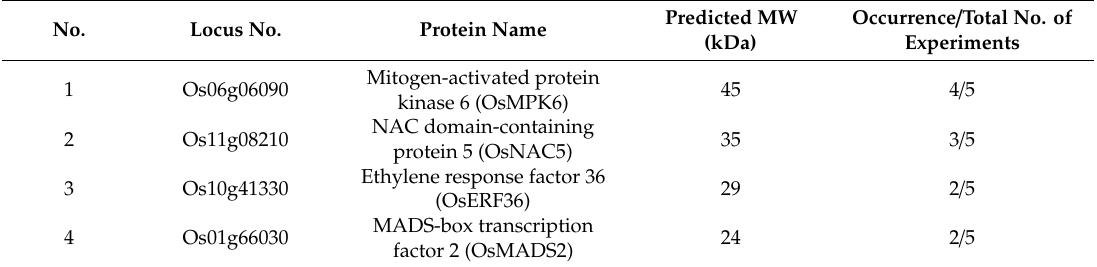
Figure 3. Identification of OsVQ13-associating proteins. ( A ) Confirmation of JA-hypersensitive phenotype in OsVQ13GFP -ox plant. Total chlorophyll content in leaf blades after treatment with 100 µ M of JA for 3 d in WT and OsVQ13GFP -ox rice plants. Values are means ± SE. Data were analyzed using Tukey’s HSD test ( n = 4 for each genotype). Bars with di ff erent letters are significantly di ff erent at p < 0.05. ( B , C ) The proteins co-purified with GFP-Trap from GFP -overexpressing ( GFP -ox: ( B )) and OsVQ13GFP -overexpressing rice plants ( OsVQ13GFP -ox: ( C )) were separated through SDS-PAGE, and protein bands were visualized by Oriole straining (Oriole). GFP ( B ) and OsVQ13GFP ( C ) proteins were detected using anti-GFP antibody (I.B.). The numbers on the left indicate the position of the protein size markers in kDa. The putative molecular weight of each protein was as follows: GFP, 27 kDa; OsVQ13GFP, 41 kDa. The numbers on the right of the Oriole staining lane in ( C ) indicate protein bands excised for MALDI-TOF MS protein identification. ( C ) The gel is representative of five independent experiments. Table 1. The list of proteins co-purified with